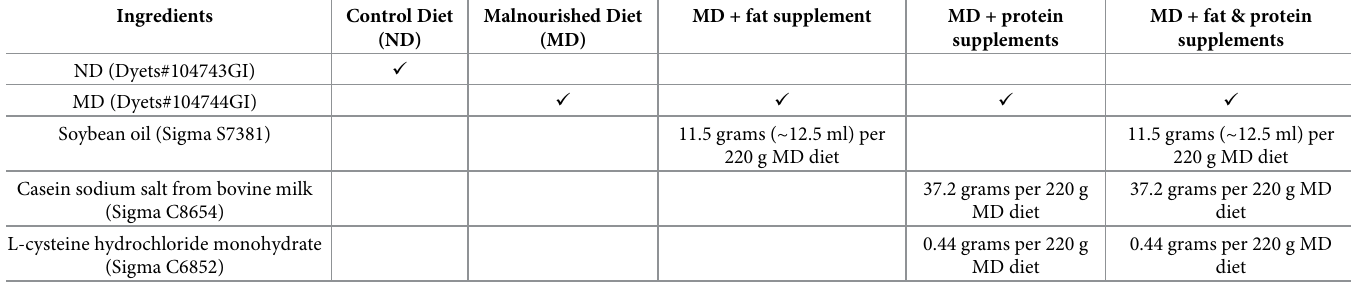
experimental procedures remained the same as before (Fig 3). Our results indicated that pro- tein supplementation in MD diets, but not fat supplementation, protected all MD progenies from a lethal dose toxin challenge (Fig 6A–6C) and resulted in an efficient maternal antibody transfer (Fig 6D) and matching FcRn expression on their F1 mothers (Fig 6E). As expected, similar results were observed when both protein and fat were supplemented to MD, indicating the importance of protein supplementation to MD diets for a more effective maternal antibody transfer from F1 to F2 during pregnancy and subsequent efficacious maternal vaccination out- comes against typhoid toxin. Table 4. Fat and protein supplementations used in this study, related to Fig 6.